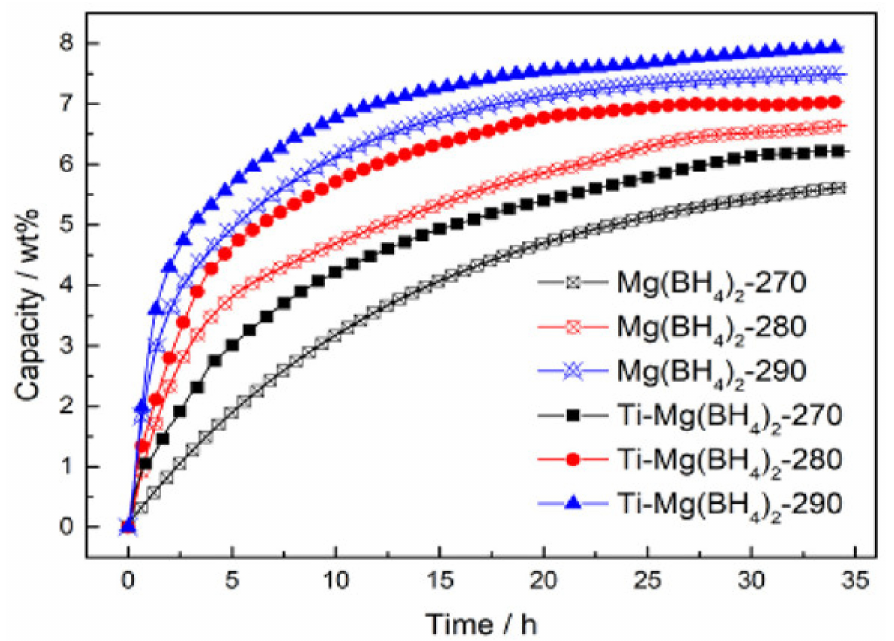
Figure 3. The dehydrogenation kinetic curves of the undoped Mg(BH 4 ) 2 and Ti–doped Mg(BH 4 ) 2 samples at 270, 280 and 290 ◦ C, respectively